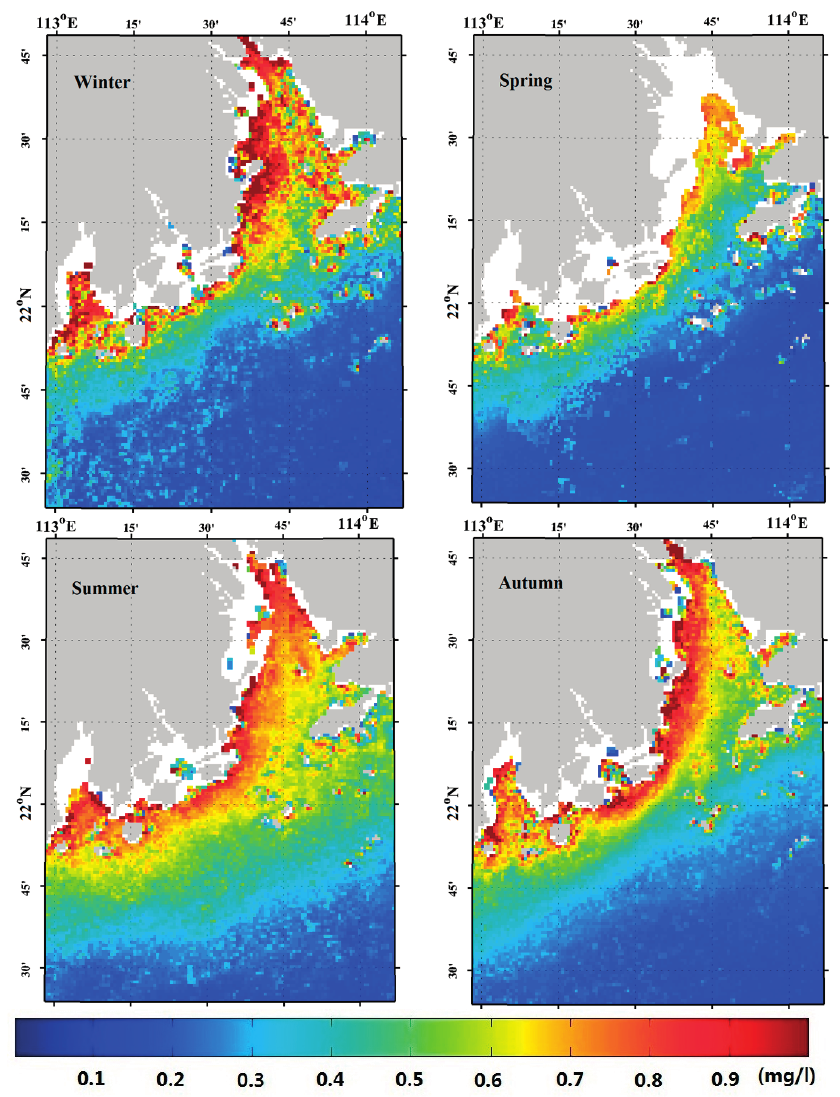
Figure 5. Seasonal POC concentrations (mg/L) derived from the MODIS/AQUA data from 2002 to 2014 using the proposed algorithm. Each season is represented by a specific month: January for winter, April for spring, July for summer, and November for autumn. The white regions are covered by highly turbid waters. Radiance of these regions was beyond the maximum radiance that band 13 or 14 of MODIS/AQUA can record, that is, band saturation occurred. Because of this, we did not obtain valid POC concentrations in the white regions. The pink line shows the vertical to water depth gradient section used to describe spatial variations of POC in the